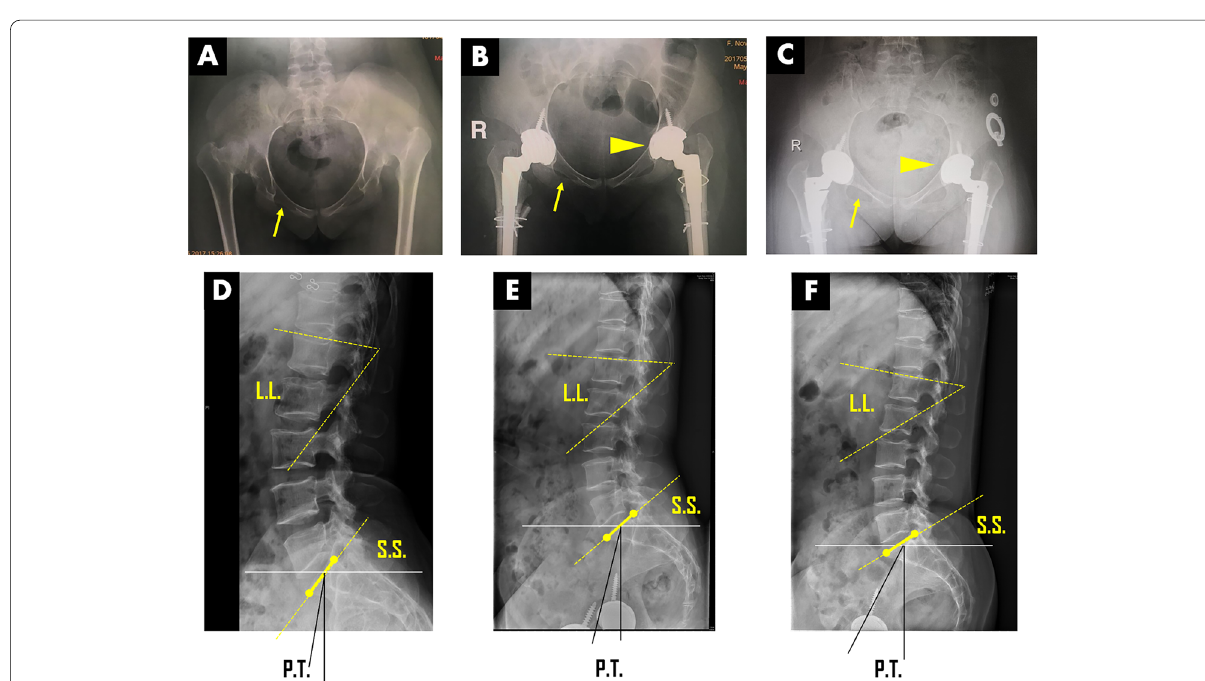
Fig. 4 Specific temporal and spatial adaption observed from anteroposterior and lateral views of lumbar-pelvis X-ray in a bilateral high-dislocated DDH patient after DAA. A , D Preoperative anteroposterior pelvis X-ray demonstrated an extremely anteverted pelvis with opened inlet and closed obturator foramen (yellow arrow). The lateral X-ray of lumbar spine showed 64° of LL, 53° of SS, and 9° of PT. B , E Hip-spine adaption at the 6 th month after surgery, the anteroposterior pelvis X-ray showed slightly retroverted pelvis with opened obturator foramen (yellow triangle). And the inclination and anteversion angles of the acetabular component were 45° and 11° in right hip, and 38° and 9° in left hip. The lateral X-ray of lumbar spine showed 43° of LL, 40° of SS, and 14° of PT. C , F Hip-spine adaption at the 10 th month after surgery, the inclination and anteversion angles of the acetabular component transformed as 48° and 16° in the right, and 40° and 15° in the left (yellow triangle). The lateral X-ray of lumbar spine showed remodeled hip-spine complex with 42° of LL, 31° of SS, and 27° of PT. Please be noted the significant morphological change of obturator foramen (yellow